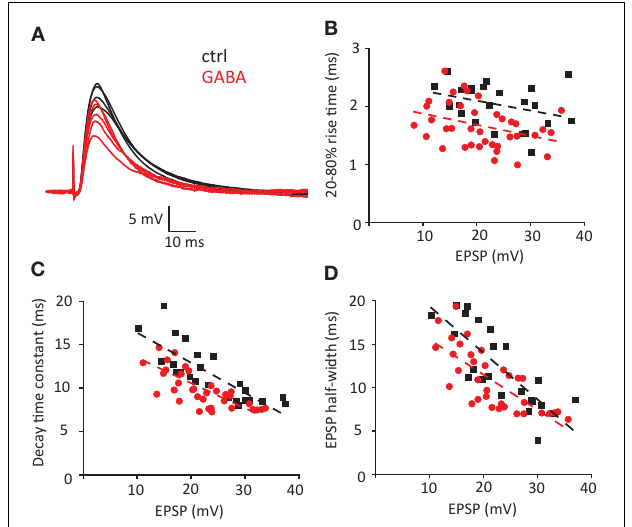
FIGURE 4 | Effect of exogenous GABA on the timecourse of EPSP/IPSP waveform triggered by stimulation of Schaffer collaterals. (A) Current clamp sample traces recorded in control conditions (ctrl) and in the presence of GABA. 5 stimuli were delivered in each cycle of stimulation to obtain EPSP distributed in the range 10–40mV. Same stimulation intensities were used in control and in the presence of GABA. Decrease in EPSP amplitude reflects shunting effect. (B–D) Individual EPSP measurements obtained in 7 cells: 20–80% rise time (B) , decay time constant (C) and half-width (D) . Black squares—control; red circles—GABA. Dashed lines of corresponding color—linear fits of the data.